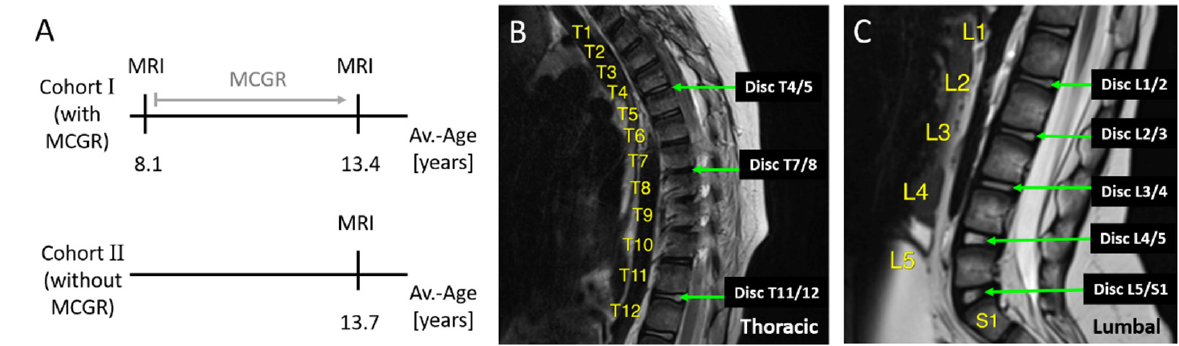
Figure 2. Cohorts and analyzed intervertebral discs. Cohort I had MRI investigations before and after on average 5.1 years of MCGR treatment. Cohort II had an MRI investigation at an average age of 13.7 years thus matching the late MRI exam of cohort I ( A ). On MRI scans intervertebral discs between thoracic vertebra 4 and 5 (T4/5), 7 and 8 (T7/8) and 11 and 12 (T11/12) were analyzed ( B ) as well as all intervertebral discs in the lumbar region ( C ).